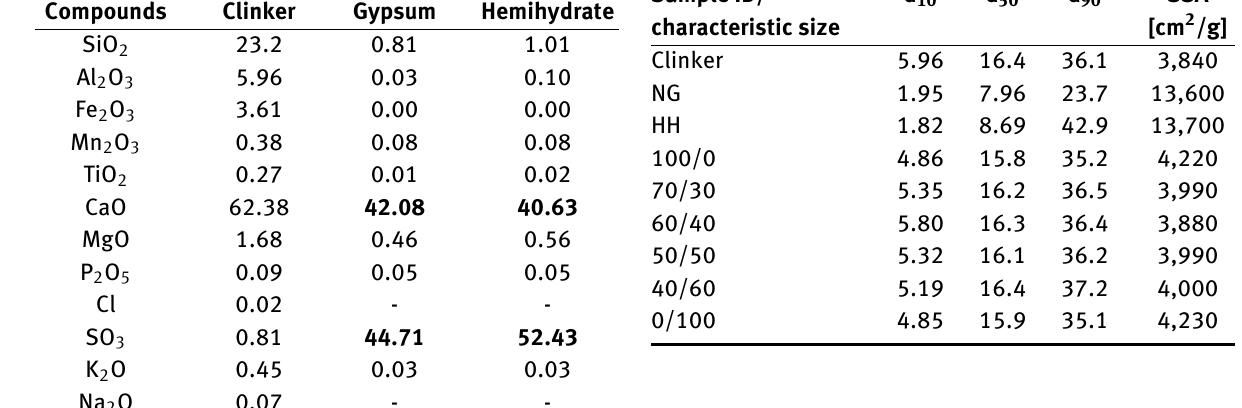
Table 1: Chemical and phase composition of clinker and calcium sulfate Compounds